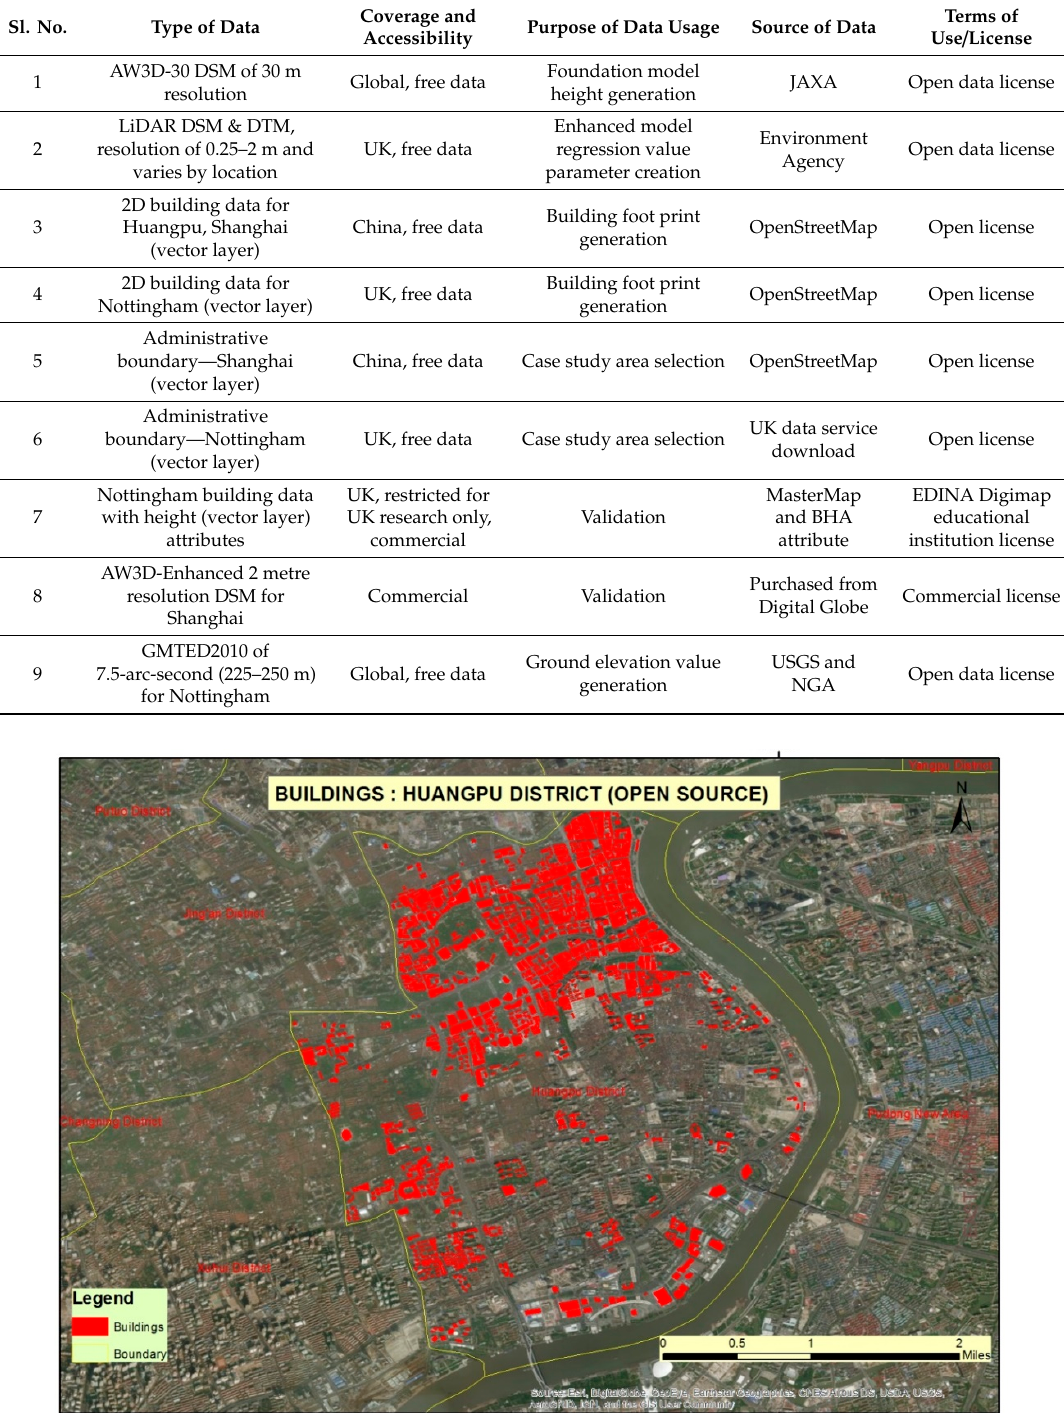
Figure 1. OpenStreetMap (OSM) building coverage, Huangpu District, Shanghai, China .